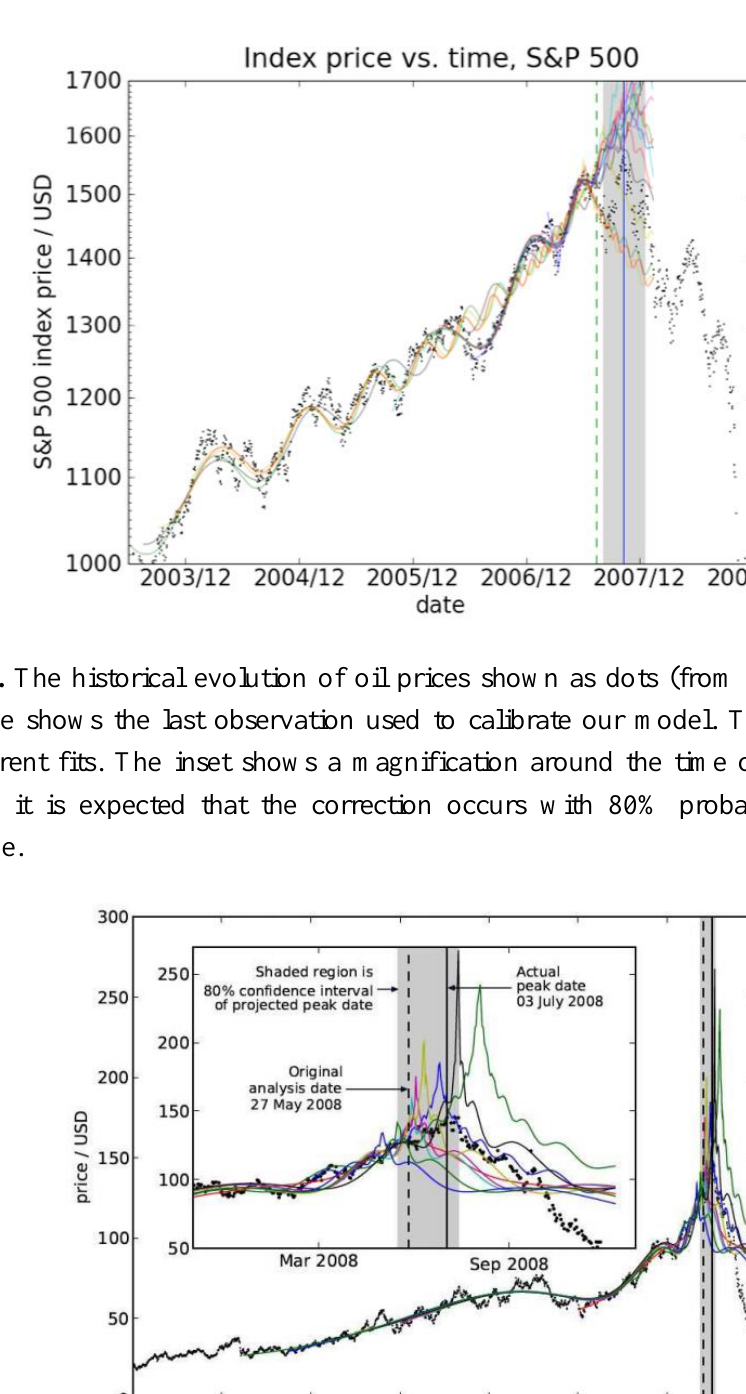
Figure 13. The historical evolution of the S&P500 index shown as dots. The dashed vertical line shows the last observation used to calibrate our model. The colored curves show different fits. It is expected that the correction occurs with 80% probability in the grey shaded zone. This indeed happened.